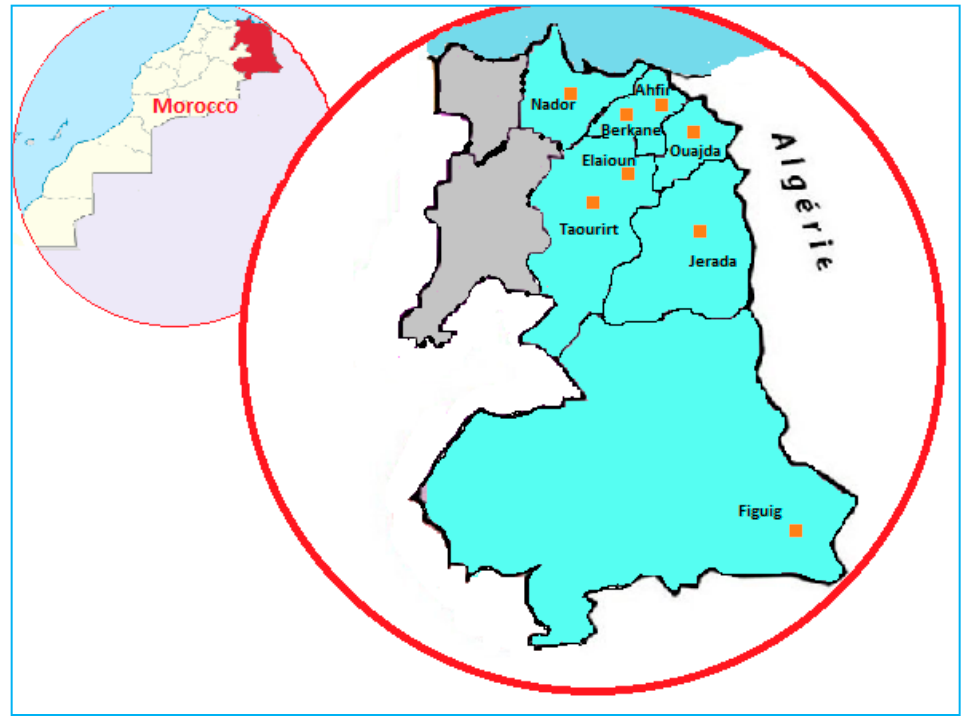
Figure 7. The map of Eeastern Morocco with the regions of investigation.